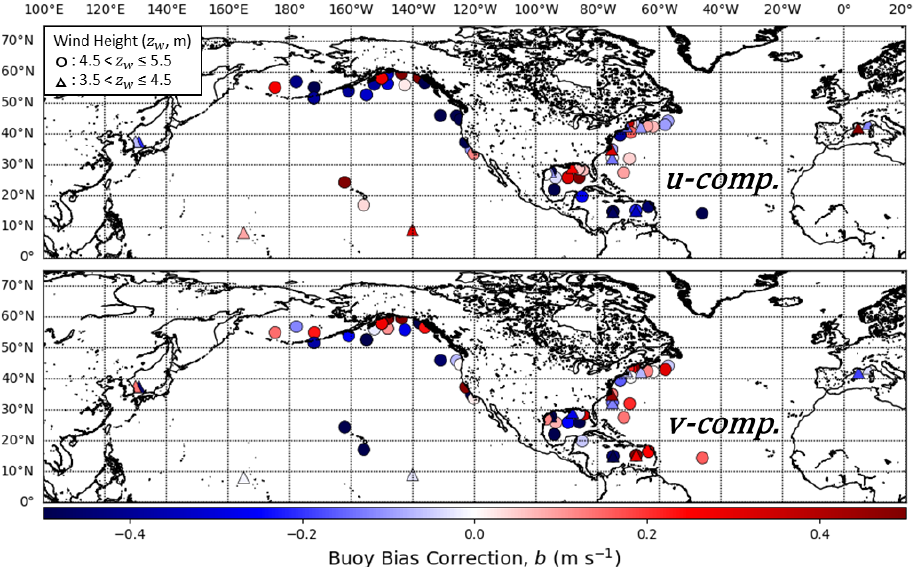
Figure 13. Triple collocation calibration bias corrections ( b ) of buoy U 10 S components calibrated with ASCAT winds as the standard for wind-wave-dominated seas ( β i > 1) at the individual buoy level. The top subplot shows the calibration bias corrections for the u -component ( b ubuoy ) and the bottom is the v -component bias corrections ( b vbuoy ). Point shapes correspond to the buoy anemometer height ranges shown in the legend. Table 4. Triple collocation calibration scaling factors and wind component bias (in parenthesis) of buoy U 10 S in wind-wave-dominant seas for NDBC buoys before and after a switch in anemometer height from 5 to near 4